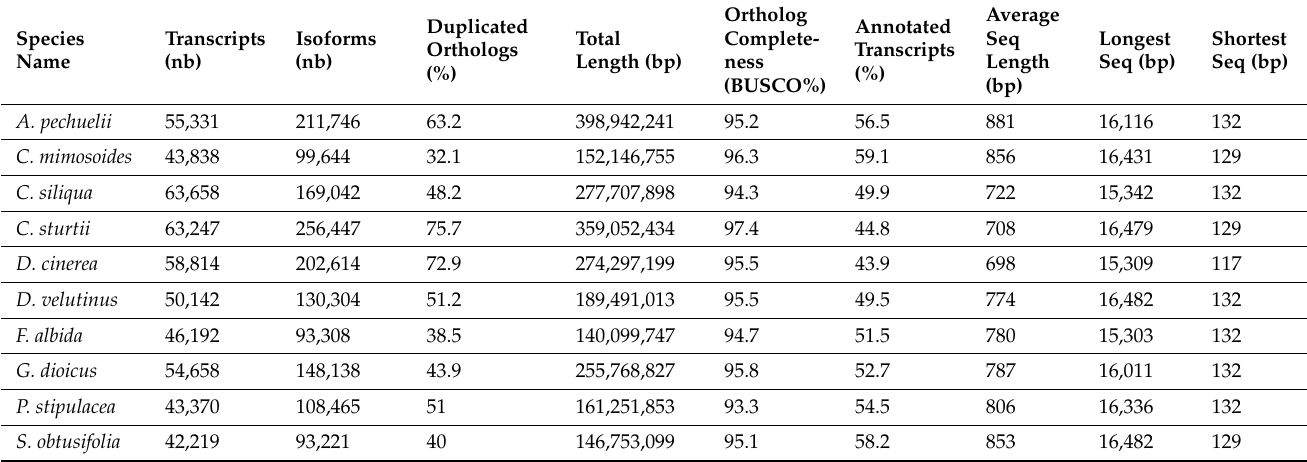
Table 1. Transcriptome assembly